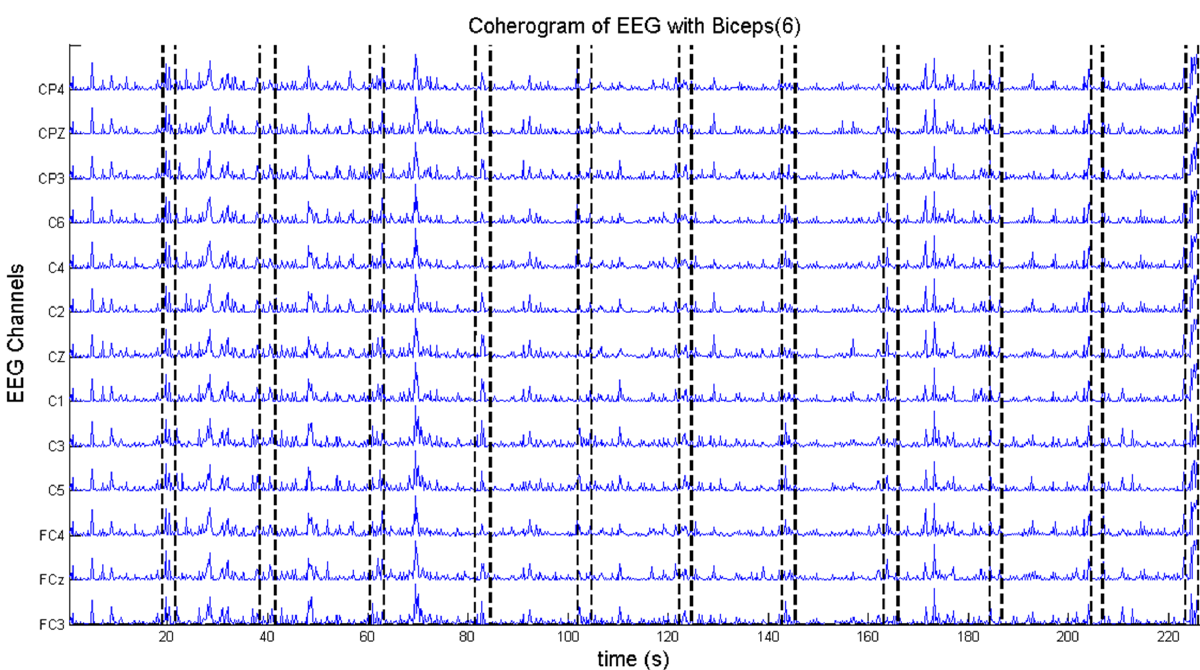
Figure 4. Coherogram showing the evolution of coherence over time during voluntary movements of the upper limb (EEG channels- central area of the brain-correlated to an EMG electrode of the biceps muscle). The black vertical dotted lines correspond to the detected